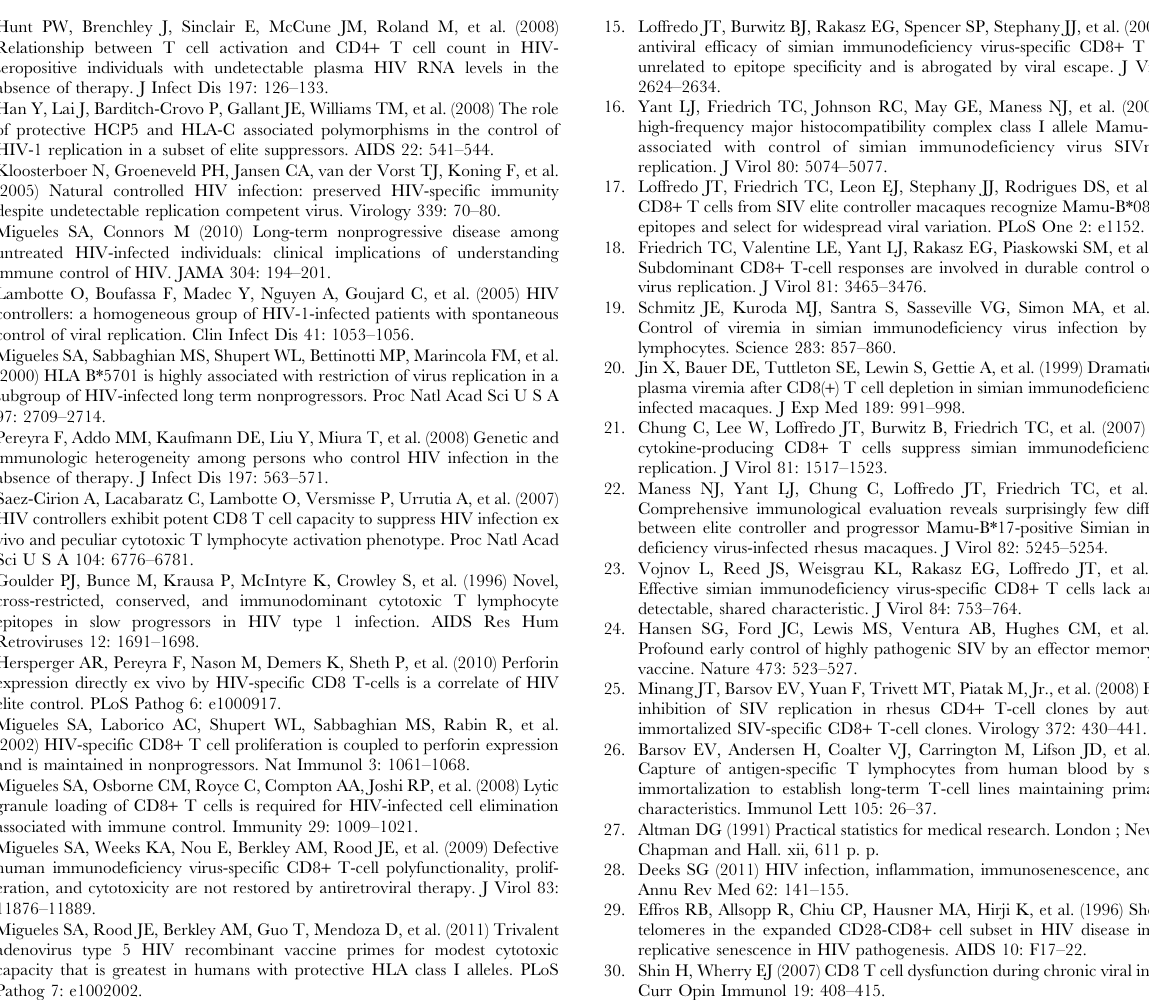
Figure S1 Determination of the percentages of IFN- c - producing SIV-specific CD8 + T cells and the percentages of SIV-infected CD4 + T-cell targets. A. IFN- c expression in the CD8 + T cells of two representative LTNP/EC macaques (top two rows) and two representative progressors (bottom two rows) is shown following stimulation for 6 hours, as described in the Methods. Values indicate percentages of gated CD8 + T cells. Red values reflect net IFN- c expression following subtraction of background IFN- c expression measured in response to uninfected targets (left column) from responses measured against SIVmac251- infected targets (right column). B. SIV p27 expression is shown in uninfected (left column) and SIVmac251-infected (right column) CD4 + T cell line targets for the same macaques as shown in A. Quadrant values indicate percentages of gated targets. Red values reflect total percentages of SIV p27-expressing targets based on the sum of the upper quadrants of plots depicting infected targets (right column). The red values from A and B are used to calculate the true E:T ratio from the plated E:T ratio for each macaque. Table S1 Determination of true E:T ratios based upon measurements of IFN- c -secreting CD8 + T-cell effectors and SIV p27-expressing CD4 + T-cell targets.